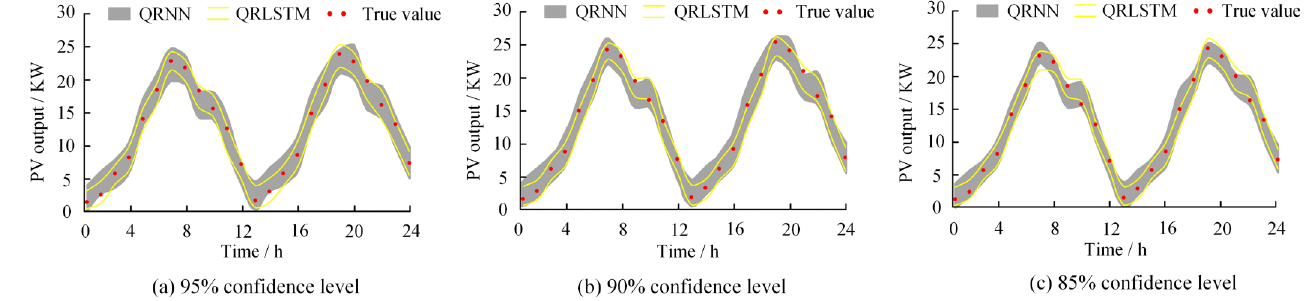
Figure 5. Comparison of interval prediction results on similar-day 1.